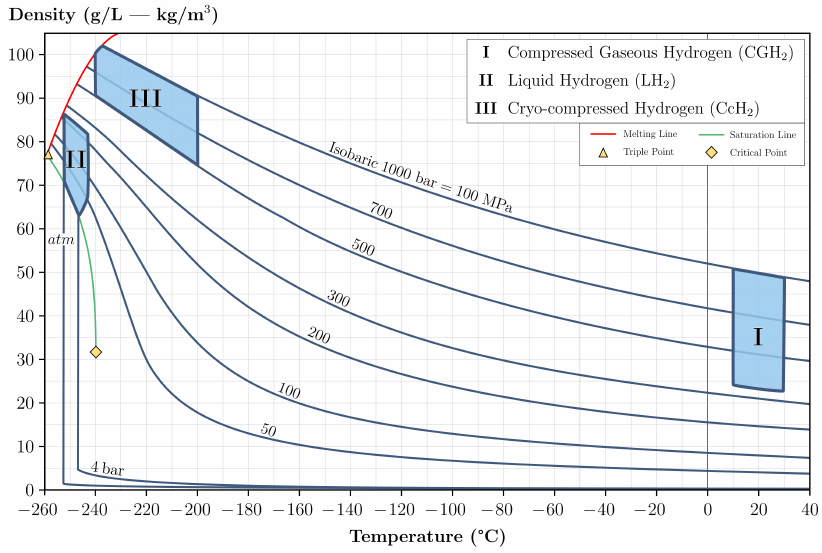
Figure 4. Correlation of hydrogen density and temperature for different conditions.